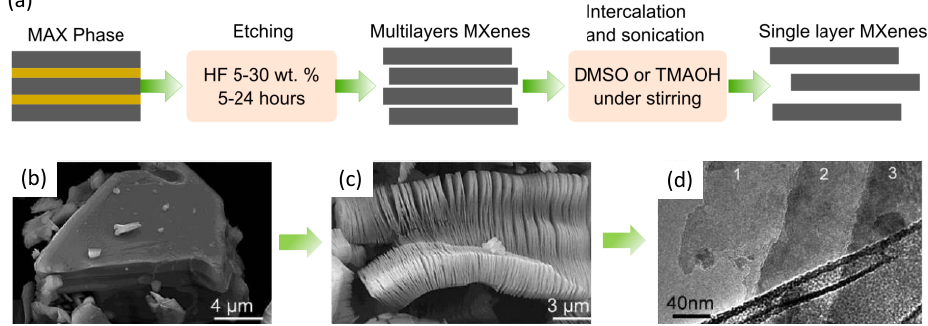
Figure 2. ( a ) General synthesis steps to produce single-layered MXenes. ( b ) Microstructure of MAX phase of Ti 3 AlC 2 particle before treatment. ( c ) Ti 3 AlC 2 after HF treatment and ( d ) Ti 3 C 2 layers formed after HF treatment of Ti 3 AlC 2 (a single sheet (monolayer) is the most transparent part of the sample). Adopted from reference with permission